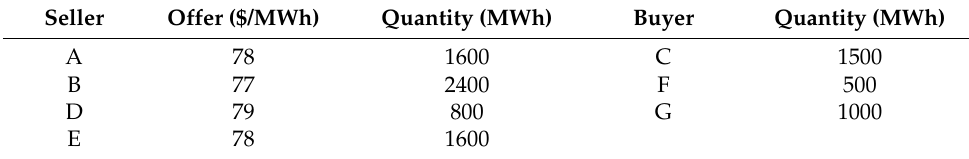
Table 3. Spinning reserve